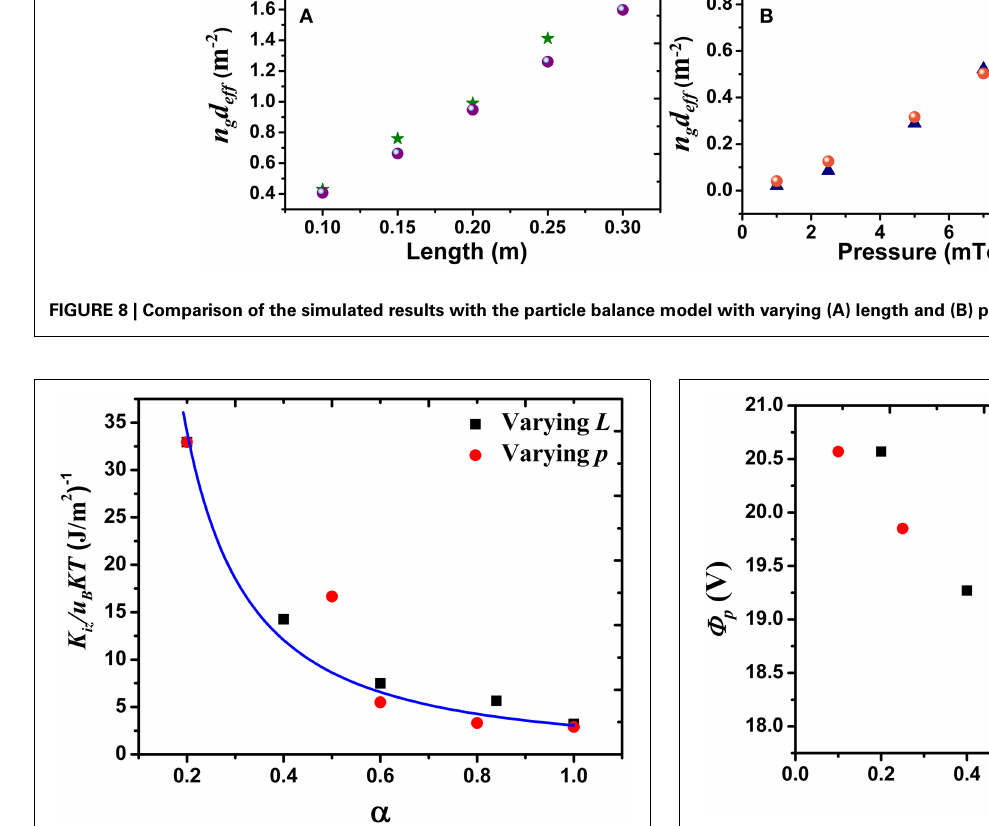
FIGURE 9 | Variation of the left hand side of Equation (10) with α for different length (black squares) and different pressures (red circles).